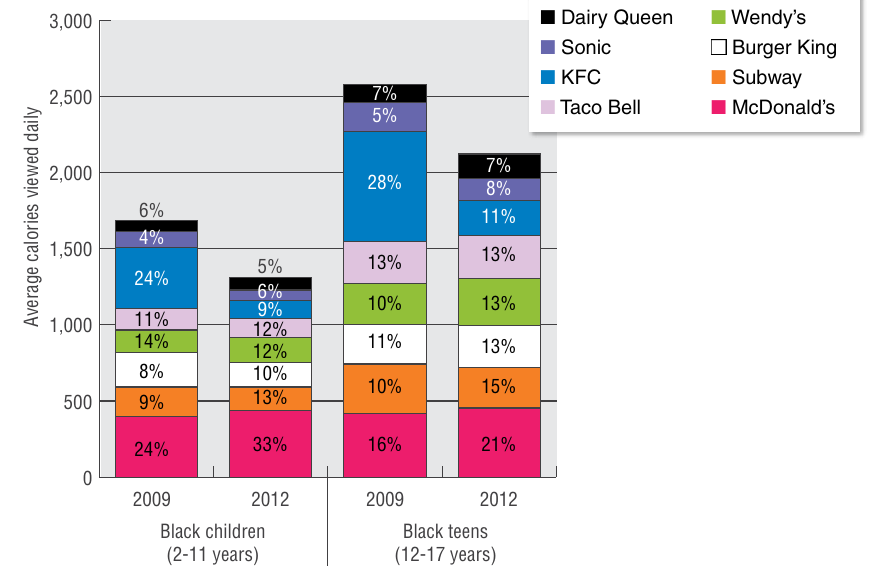
Source: Nielsen (ad exposure data, 2009 and 2012); menu composi- tion analysis (February